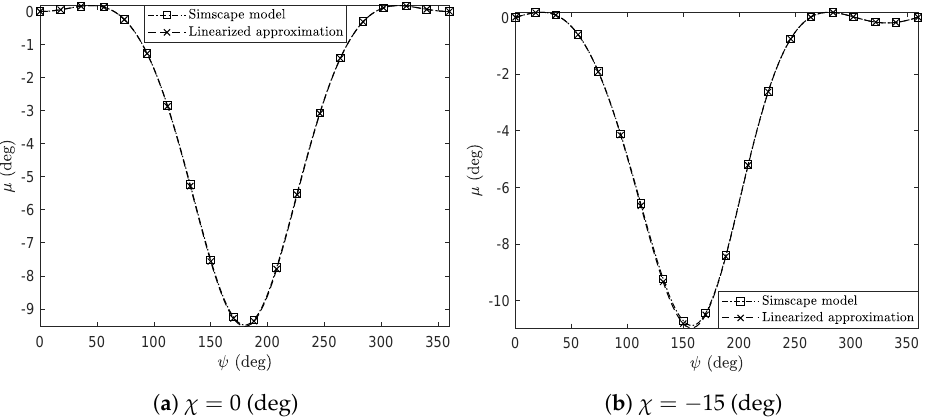
Figure 14. Variation of the rear frame pitch angle approximation in Equation (55) for a complete rotation of the vehicle handlebars. ( a ) considers the case of a constant roll angle of the rear frame equal to zero. ( b ) shows the pitch angle variation for a constant roll angle of the rear frame equal to χ = − 15